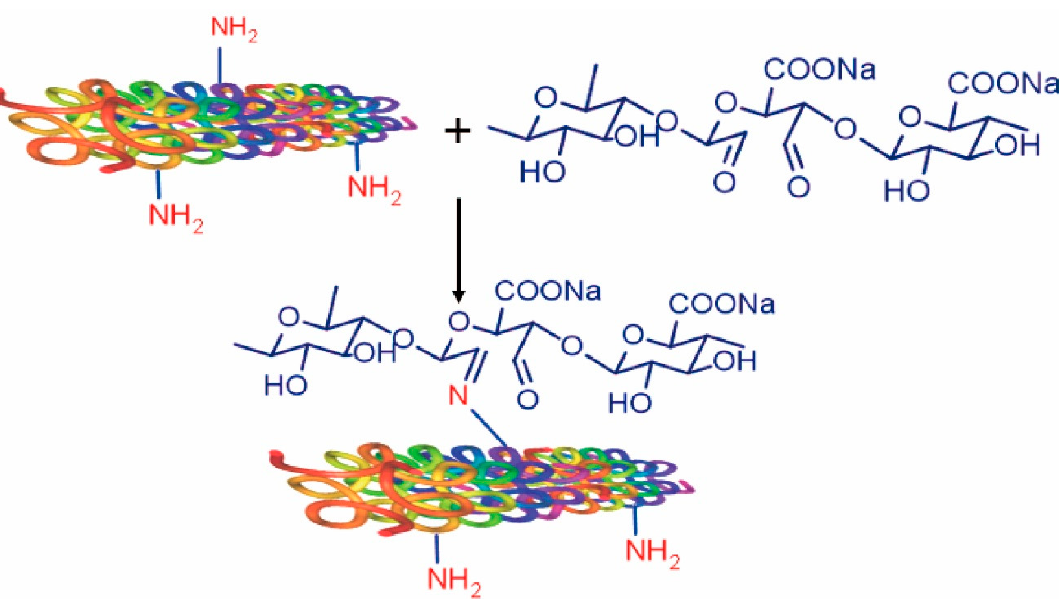
Figure 7. The diagram of the reaction for possible crosslinking between collagen and alginate dialdehyde (ADA).